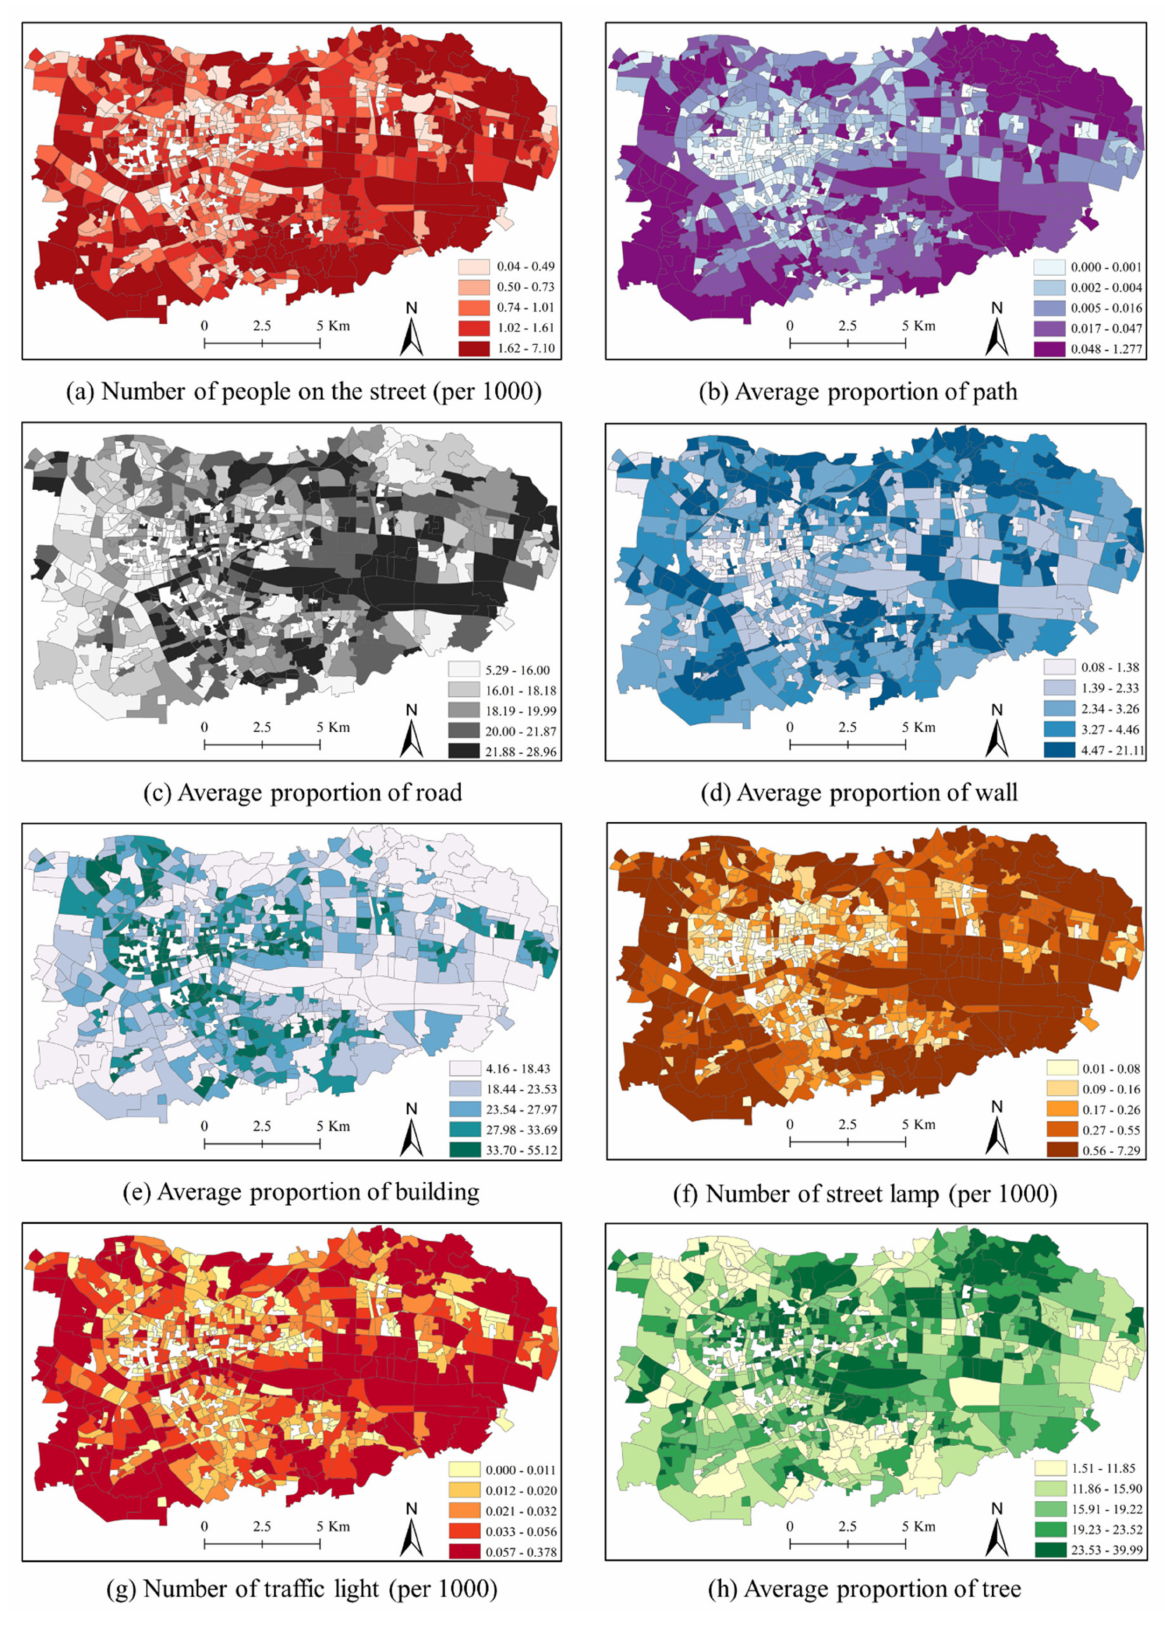
Figure 4. Spatial distributions of people on the street and streetscape physical features retrieved by BSV images and deep learning